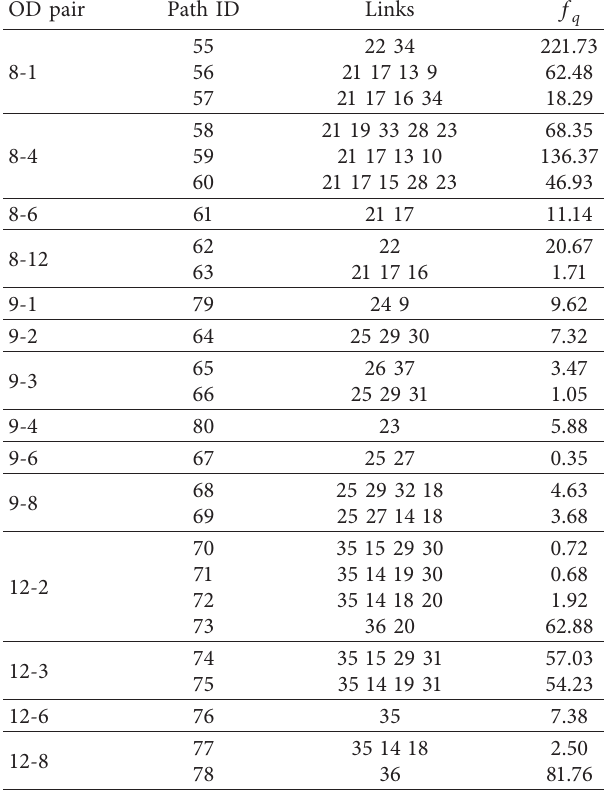
Table 6: Sets of routes resulting after the application of Step 1 � according to F thres